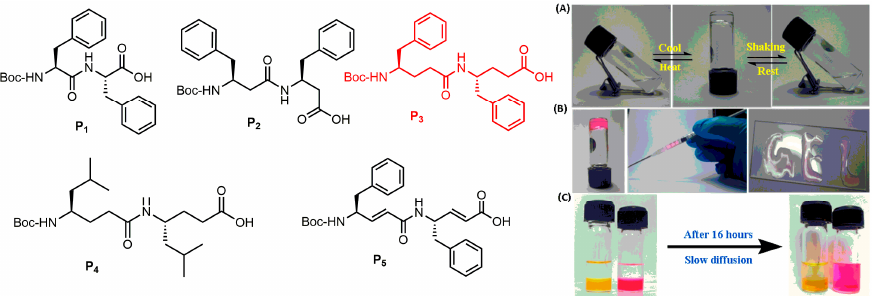
Figure 8. ( Left ) Chemical structures of peptides P1 − P5 . ( Right ) ( A ) Stimuli-responsive behavior of peptide P3 hydrogels; ( B ) Injectable nature of peptide P3 hydrogels; ( C ) Slow release of proflavine (yellow) and rhodamine (pink) from hydrogel matrix to the buffer layer after 16 h. Image adapted with permission from reference [51]. Copyright 2017 American Chemical Society.